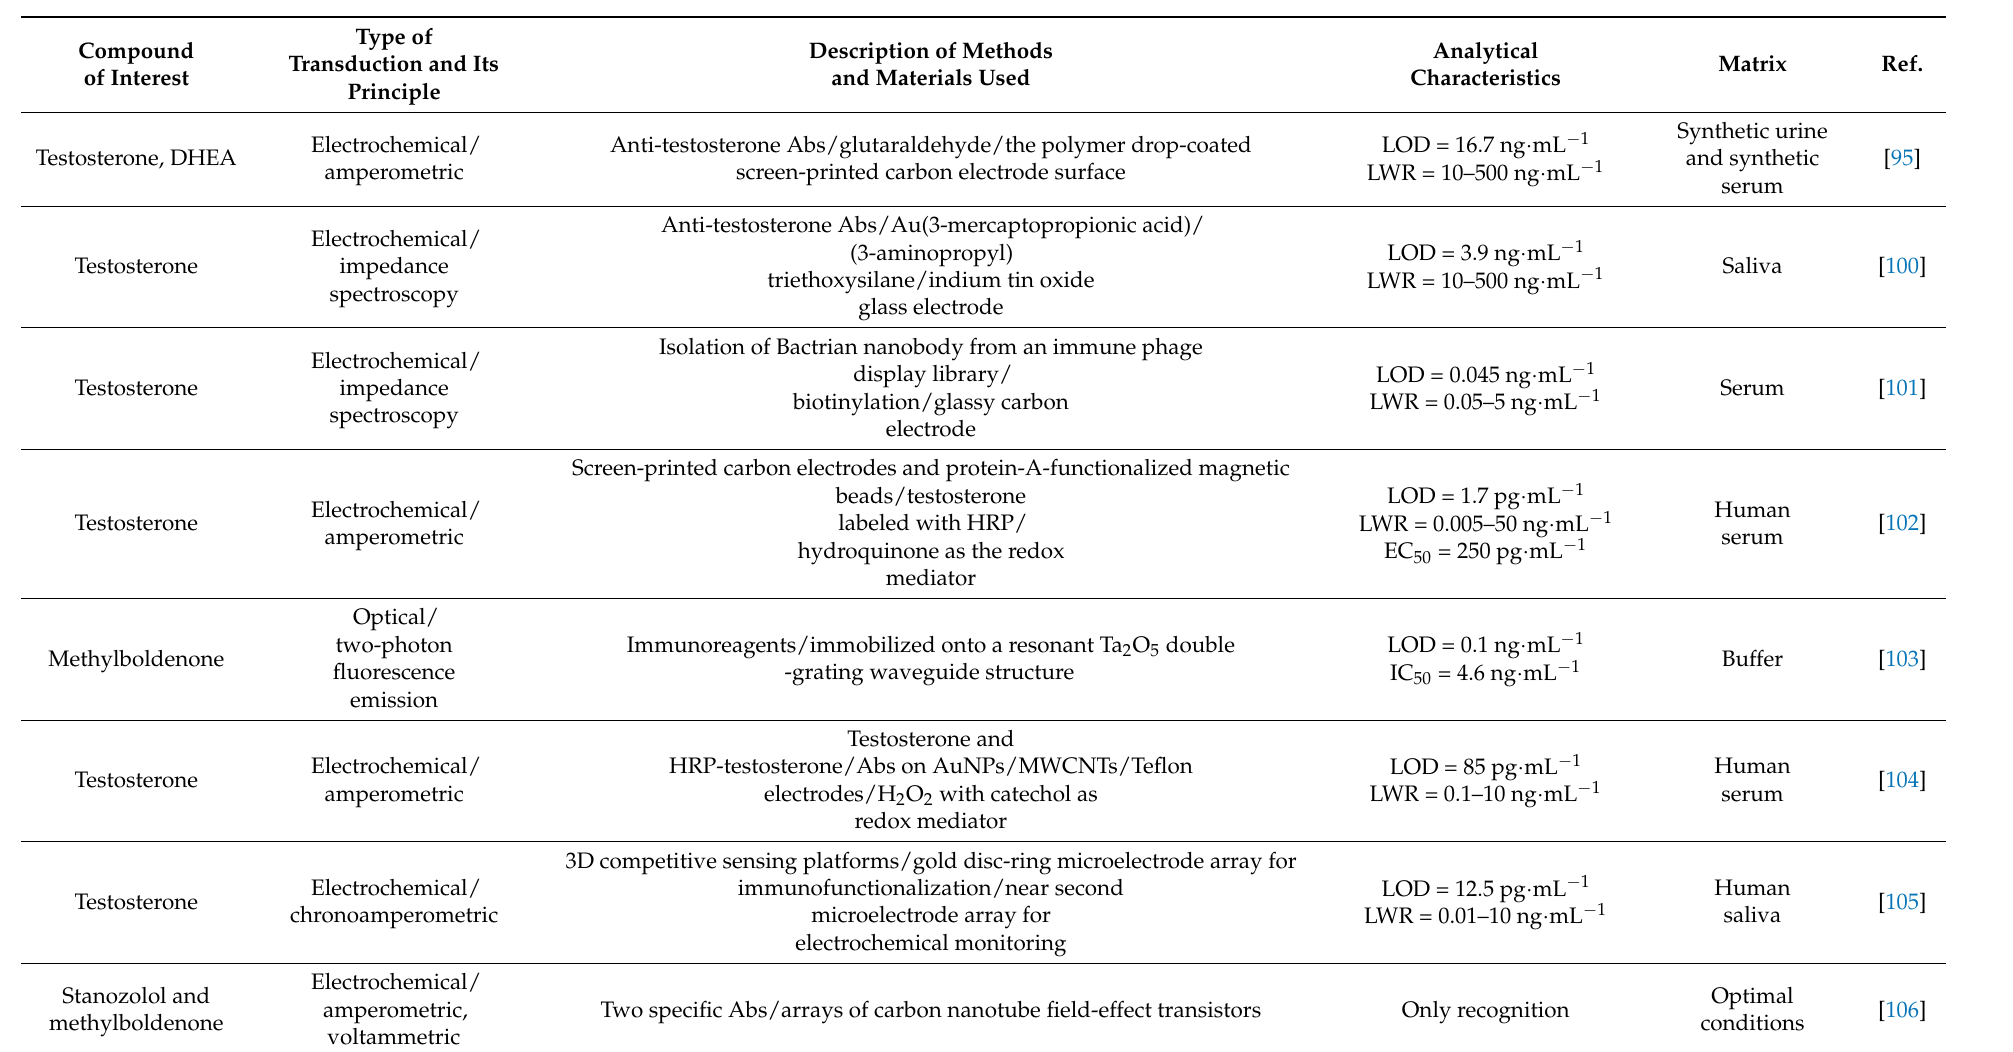
Table 4. Immunosensors for the determination of anabolic-androgenic